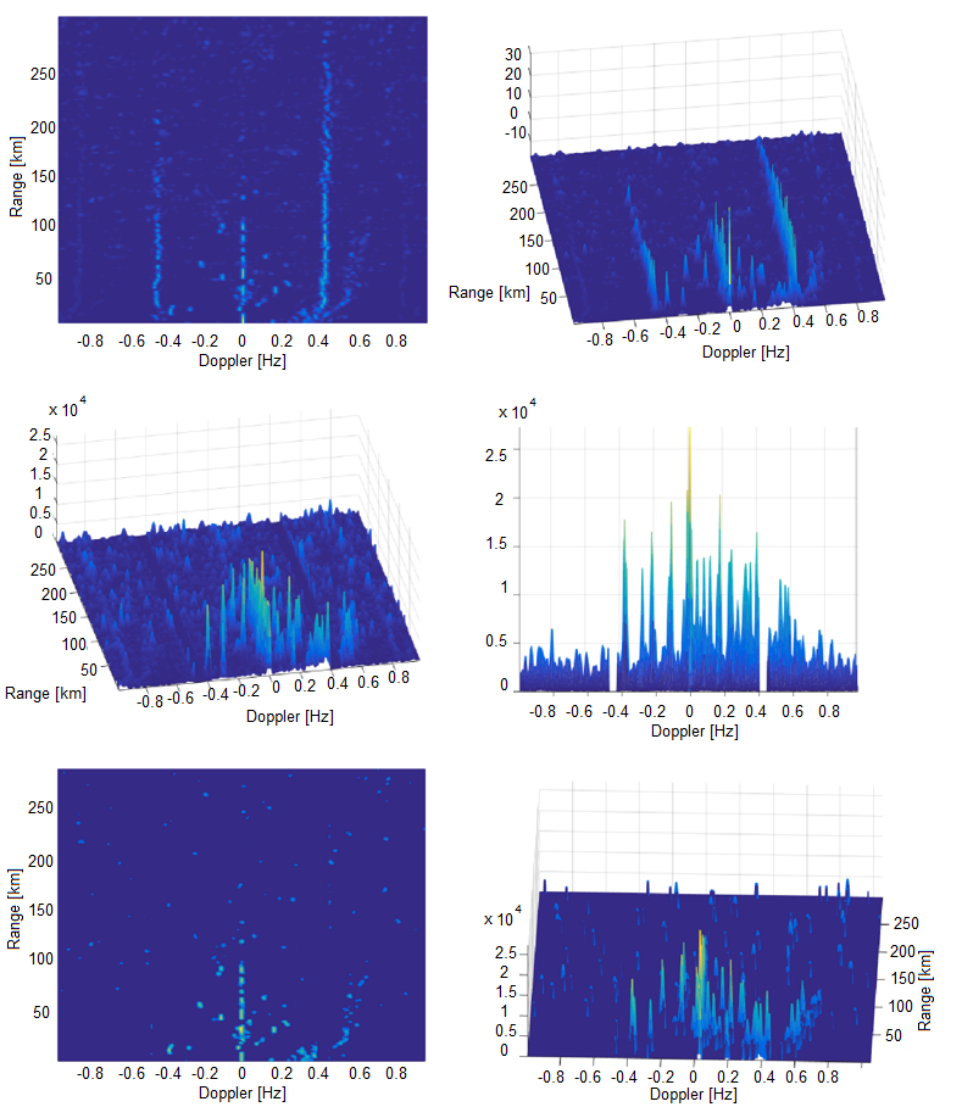
Figure 12. RD-HR map at the beginning of the process ( top ), RD-HR map after median filtering and Bragg’s lines elimination ( middle ) and HD HR map after convolution process ( bottom